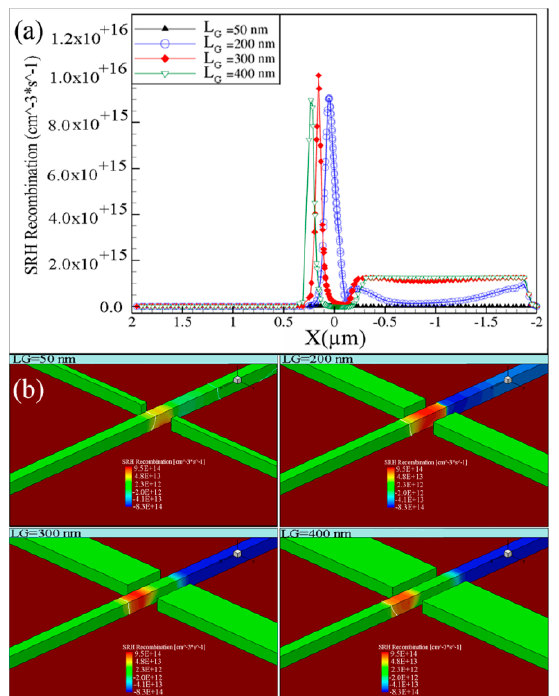
Figure 6. ( a ) The SRH recombination–generation rate along a cutline at Z = 50 nm and ( b ) a bird eye view for devices with different L G for a V G = +2 V and = V D = − 1 V.